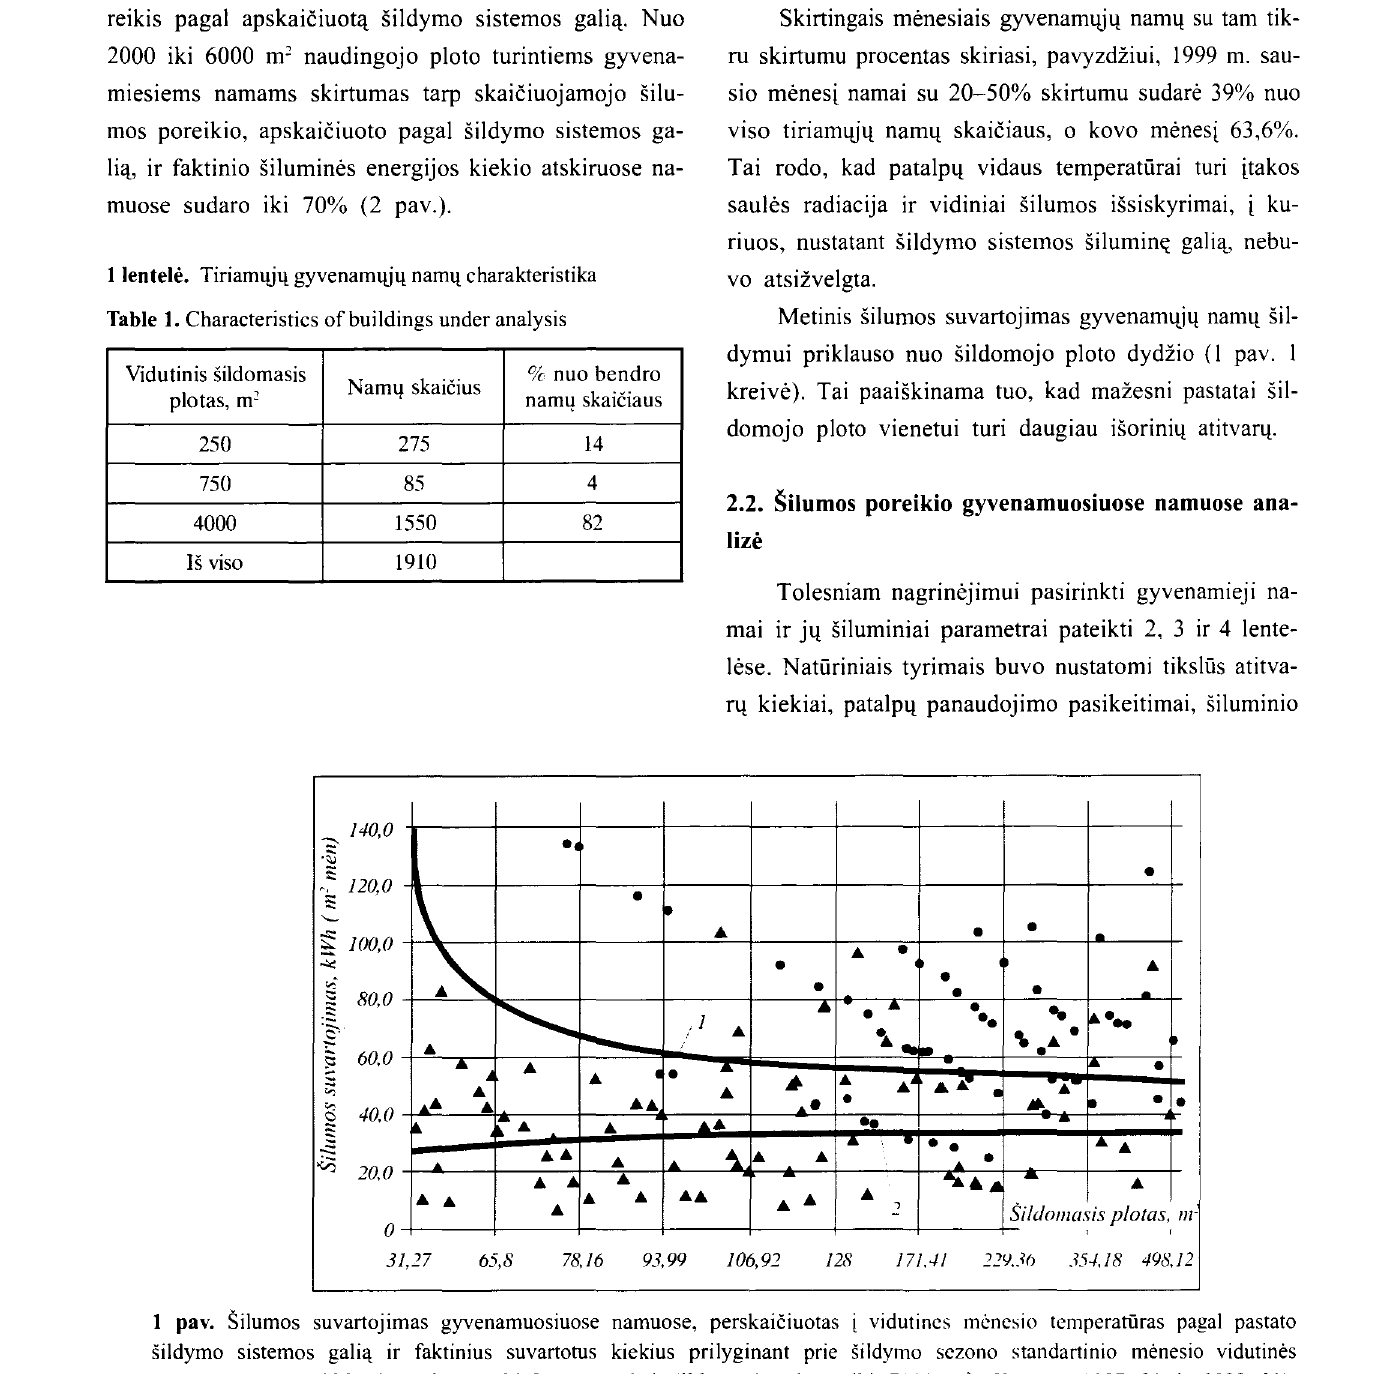
Table 1. Characteristics of buildings under analysis